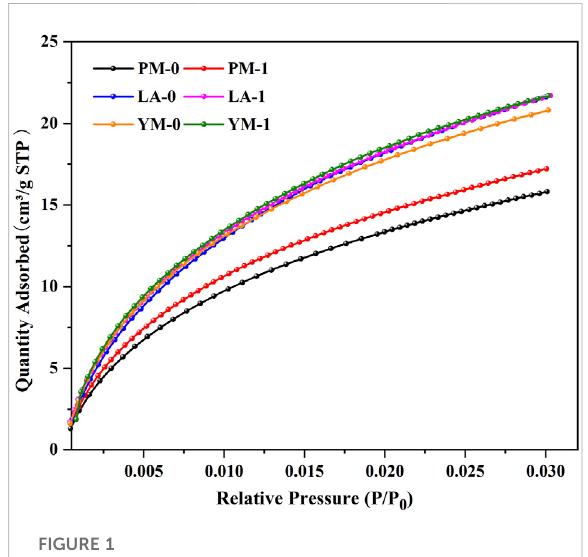
FIGURE 1 LPGA-CO 2 adsorptionisothermsoftherawandacidi fi edcoal